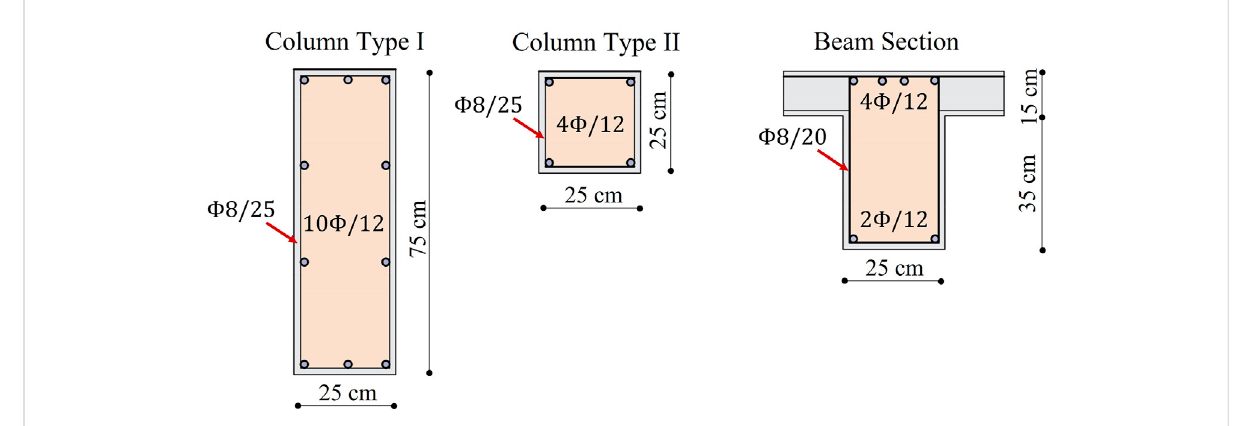
FIGURE 4 Reinforcement layouts of column and beam